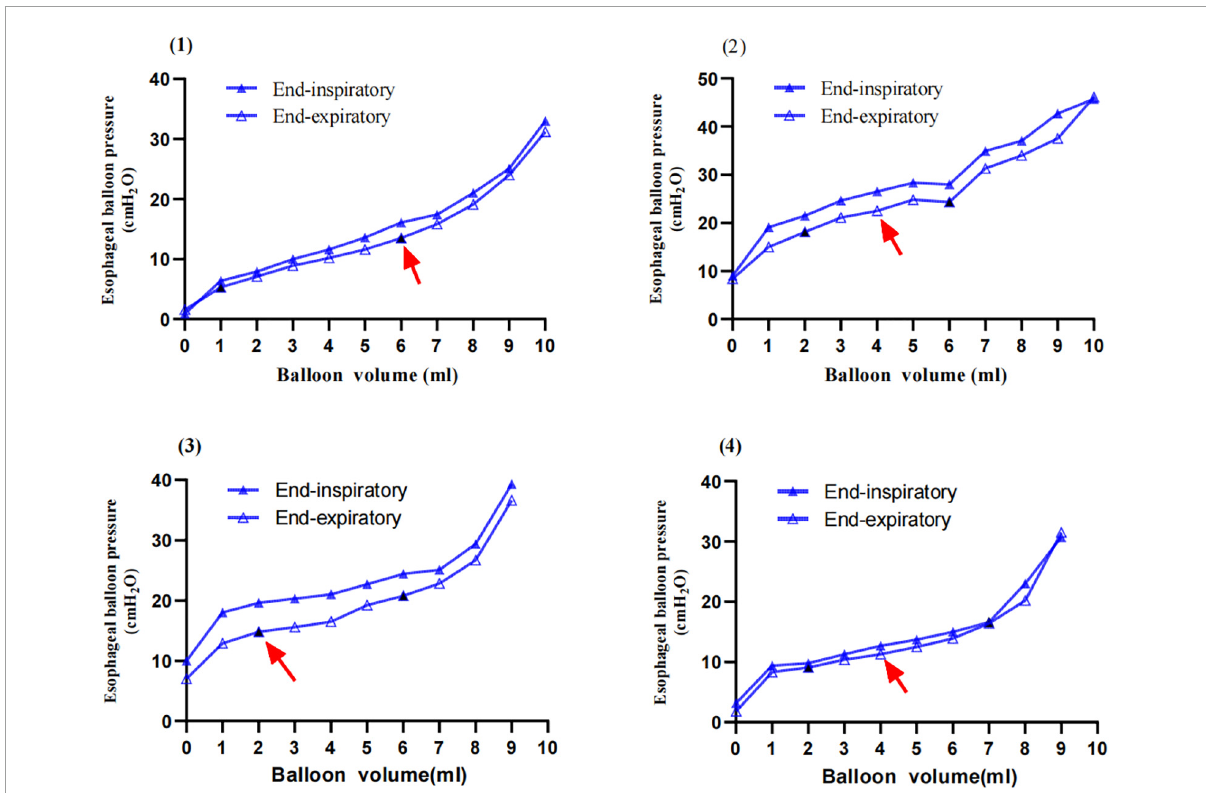
FIGURE2 Examples of inspiratory and expiratory esophageal balloon pressure-volume curves. The solid blue triangle refers to end-inspiratory esophageal pressure (PesEI); the hollow blue triangle refers to end-expiratory esophageal pressure (PesEE). The solid black triangle refers to V MIN and V MAX , and the red arrow represents the V BEST . (1) A 42-years-old female patient, BMI 21.5 kg/m 2 , with severe pneumonia (methicillin-sensitive Staphylococcus aureus, MSSA), pulmonary ARDS with focal lesion, VV-ECMO. PC 8 cm H 2 O, PEEP 10 cm H 2 O, TV 200.9 ml, Pplat 18 cm H 2 O, esophageal elastance 1.59 cm H 2 O/ml, and Pew at V BEST 7.97 cm H 2 O; V MIN 1 ml; V MAX 6 ml; and V BEST 6 ml. (2) An 18-years-old female patient, BMI 23.4 kg/m 2 , with infective endocarditis (IE), severe pneumonia (methicillin-resistant staphylococcus aureus, MRSA) and post-operative mitral valve replacement and ARDS with Diffuse lesion; PC 13 cm H 2 O, PEEP 8 cm H 2 O, TV 216.5 ml, Pplat 26 cm H 2 O; V MIN 2 ml, V MAX 6 ml, and V BEST 4 ml, esophageal elastance 1.61 cm H 2 O/ml, and Pew at V BEST 3.22 cm H 2 O. (3) A 29-years-old male patient, BMI 38 kg/m 2 , with severe acute pancreatitis (SAP), abdominal compartment syndrome (ACS), extrapulmonary ARDS with diffuse lesion, VV-ECMO; PC 10 cm H 2 O, PEEP 15 cm H 2 O, TV 475 ml, Pplat 25 cm H 2 O; V MIN 2 ml, V MAX 6 ml, and V BEST 2 ml, esophageal elastance 1.56 cm H 2 O/ml, and Pew at V BEST 0 cm H 2 O. (4) A 74-years-old male patient in the prone position, BMI 24.8 kg/m 2 , with severe pneumonia, septic shock, ARF with diffuse lesion;